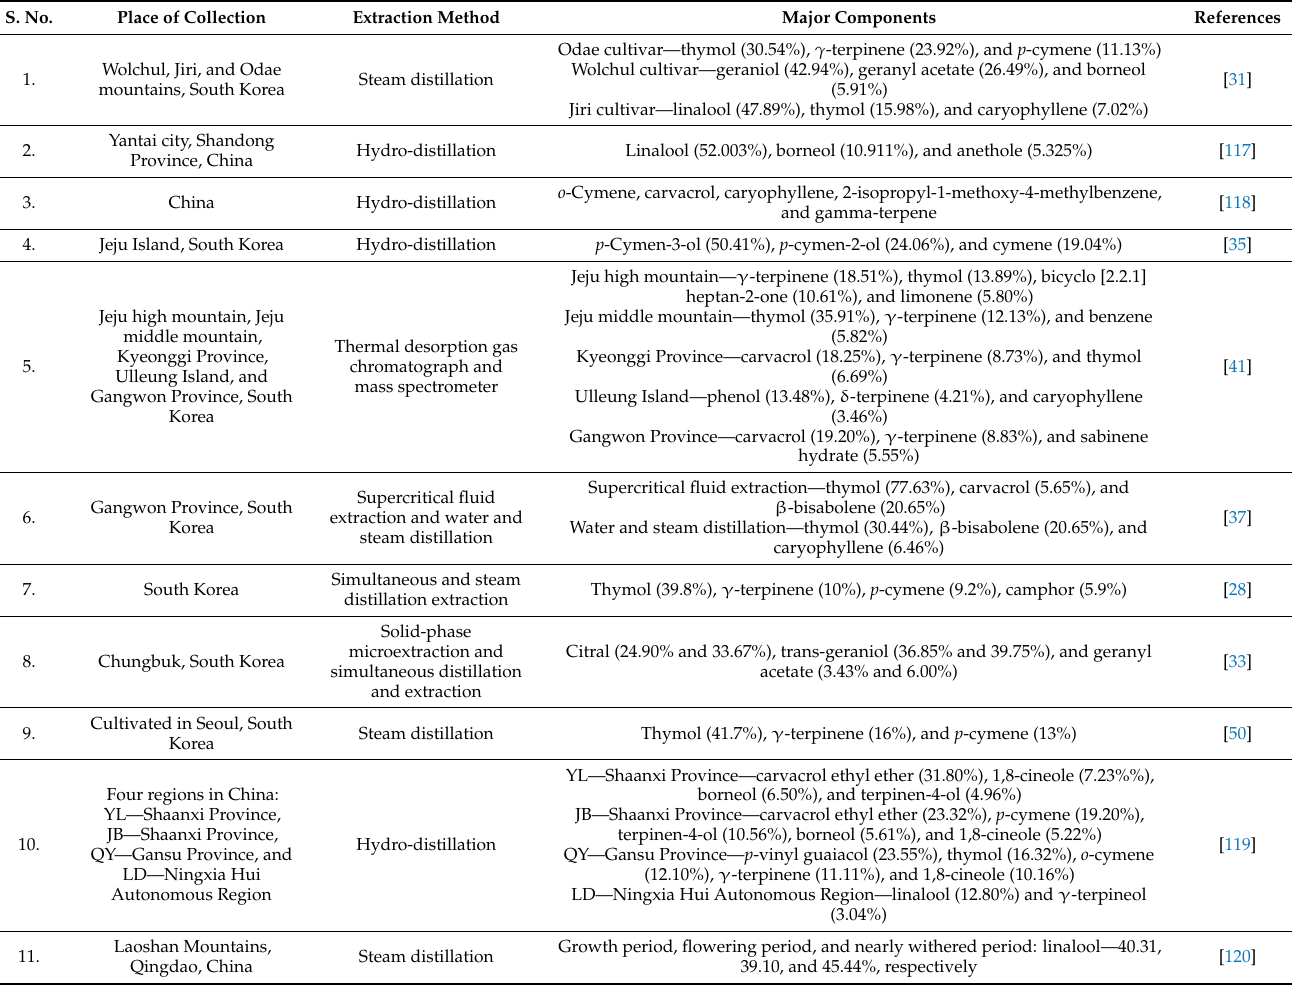
Table 1. Essential oil isolation from Thymus quinquecostatus and its major